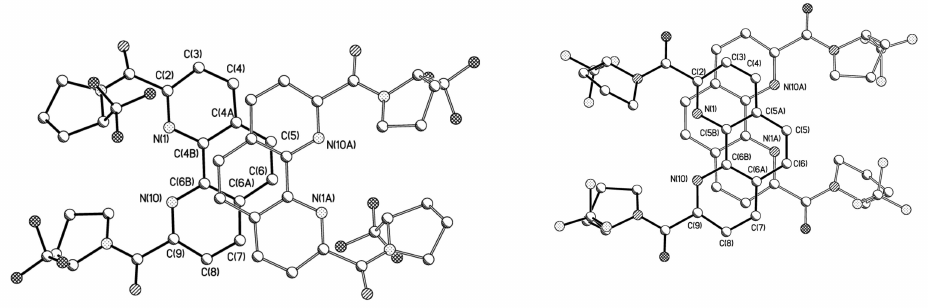
Figure 5. The molecular packing of (left) 1A and (right) 1B · H 2